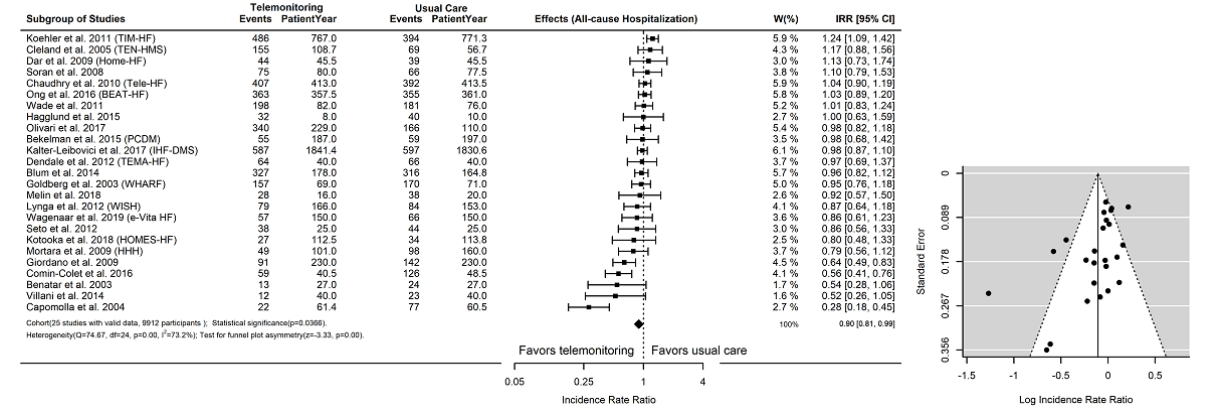
Figure 5. Event counts and effectiveness of telemonitoring interventions on all-cause hospitalization. There were 24 randomized controlled trials (N=9612) with hospitalization event counts in the subgroup meta-analysis. IRR: incidence rate